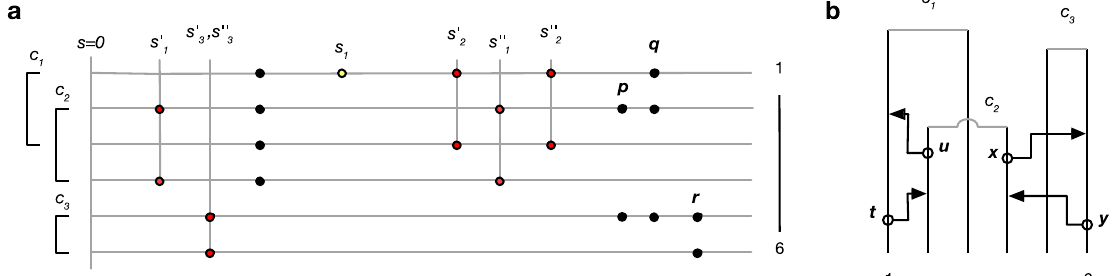
Fig 1. a. Example of data digest. Lines represent genomes of 6 lineages, circles observed genetic variants. Of the data shown, one singleton (yellow) and five doubletons (red) contribute to the digest. Cherry c 3 is supported by a single doubleton; r does not contribute because the mutation patterns p and q are incompatible with c 3 . Similarly, p does not contribute because it is incompatible with c 2 and c 3 . b . Partial genealogy (unbroken lines) over 6 lineages. Open circles and arrowheads represent potential recombination and coalescence events that would change the terminal branch length for lineage 1 ( t , u ), and remove cherry c 3 ( x , y